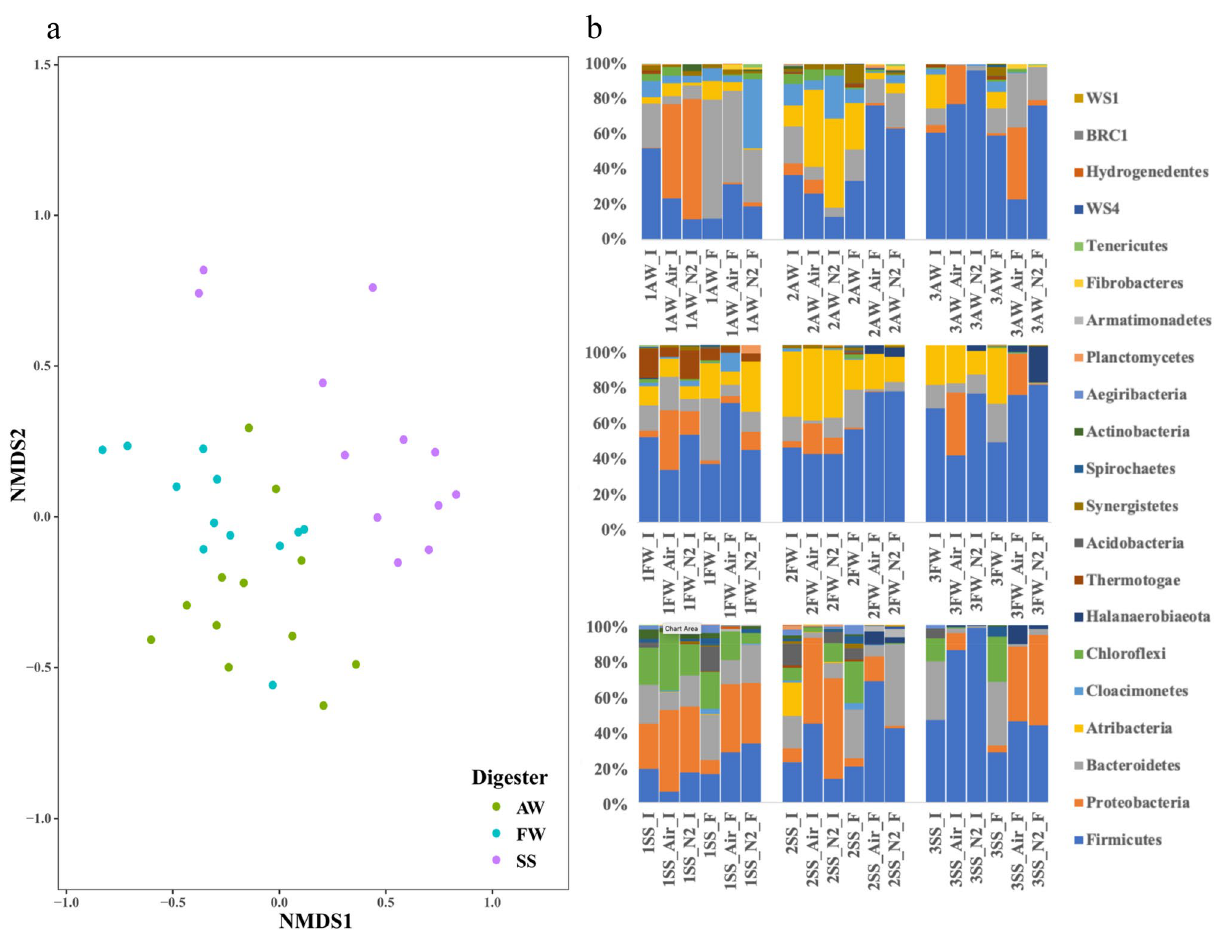
Figure 2. Bacterial community structure of the three types of sludge (AW: agricultural waste, FW: food waste, and SS: sewage sludge). ( a ) Nonmetric multidimensional scaling (NMDS) analysis based on ASV read counts displaying bacterial community distribution coloured by sludge types. ( b ) Relative abundance of the bacterial community at the phylum level of three types of sludge separated after the drying-rewetting (sample name end with “I”) and incubation events (sample name end with “F”). From top to bottom, the bar plots correspond to the agricultural waste, food waste, and sewage sludges. From left to right, the bar plots correspond to the